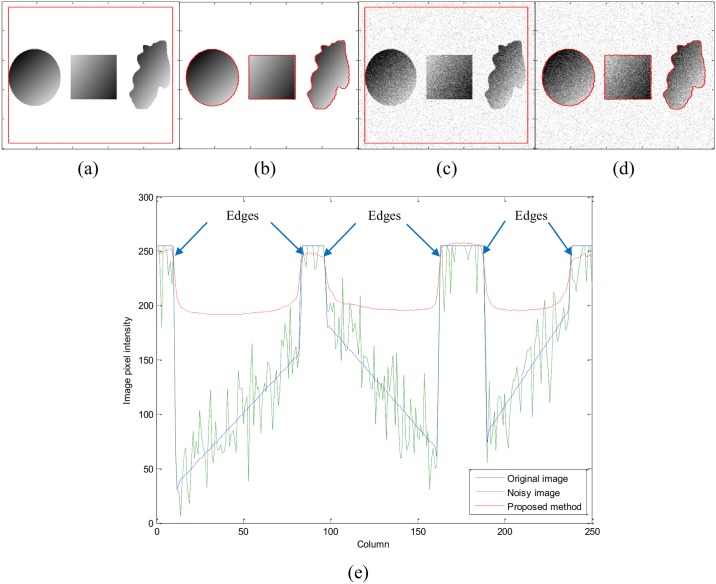
Segmentation results on synthetic images with intensity
inhomogeneity with and without noise.(a) Original image with initial contour, (b) Segmentation result using original image without noise, (c) Noisy image with initial contour, (d) Segmentation result using noisy image, (e) Profile selection of the middle rows of the original image (blue line), noisy image (green line) and level set of proposed method (red line).